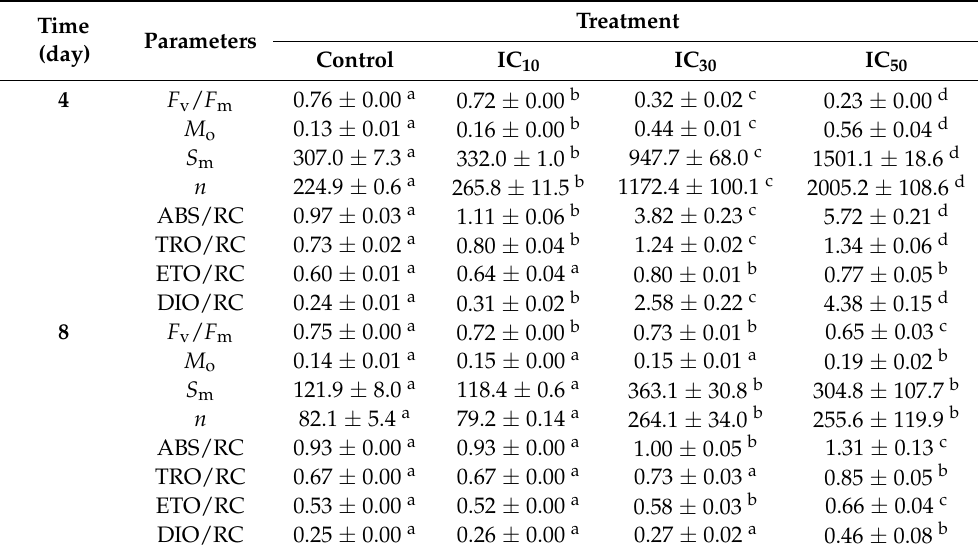
Table 2. Comparison of the photosynthetic parameters of the microalga Scenedesmus obliquus exposed to tetracycline for 4 and 8 days in the different treatments. For each parameter, the data with the same superscript letter indicate no significant difference ( p <